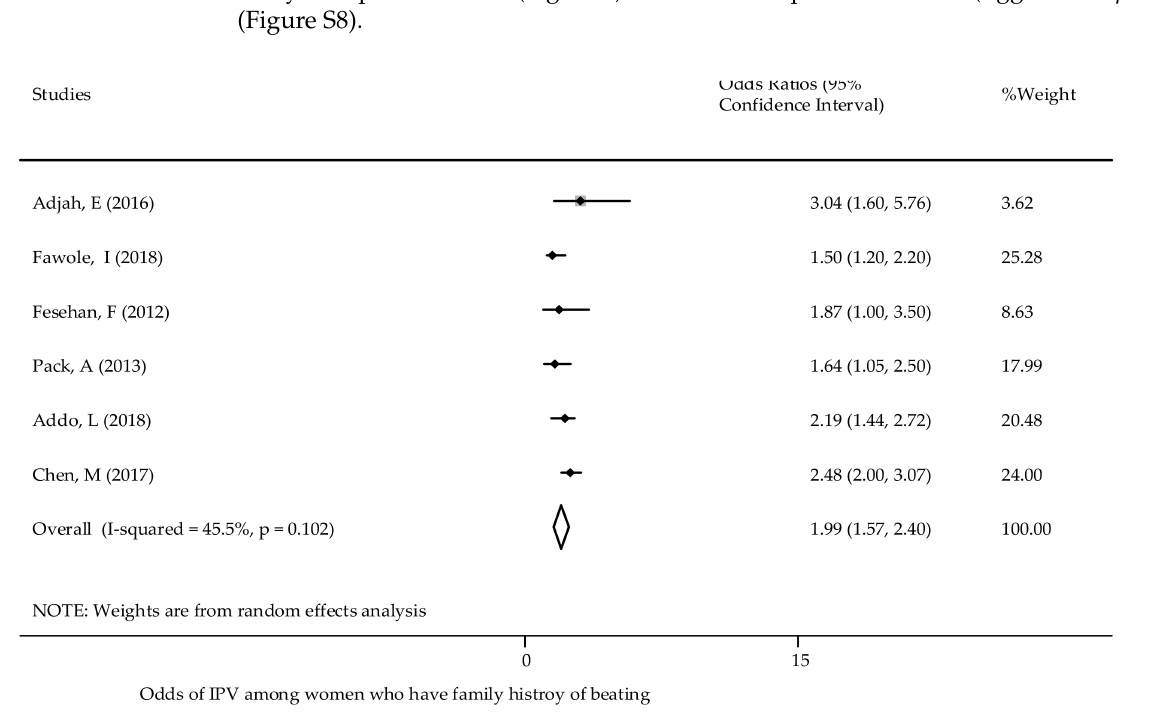
Figure 8. The association of family history of physical violence and experience of reporting GBV in